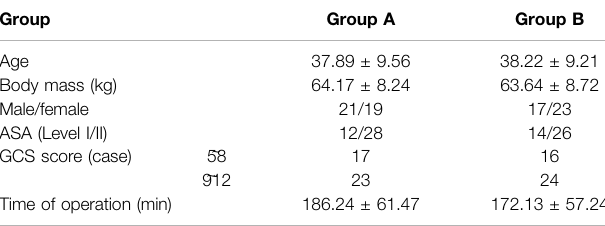
TABLE 1 | Comparison of general condition indexes and operation time between the two groups (n =